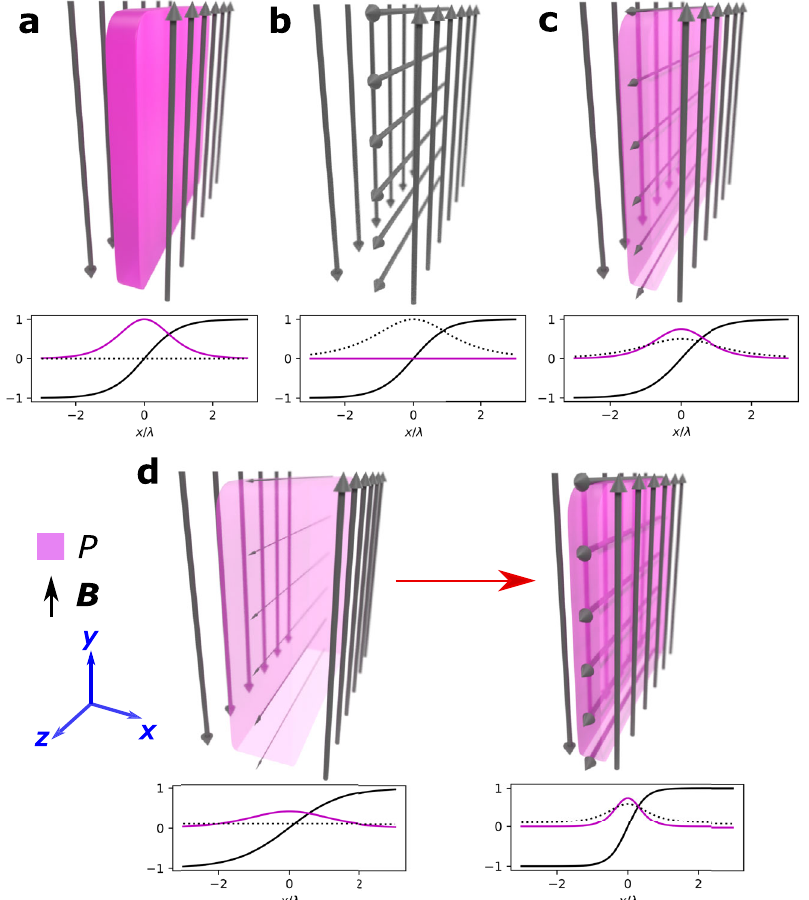
Fig. 1 | Current sheet types. Graphical illustrations of the a Harris equilibrium, b force-freeequilibrium,and c mixedequilibrium. d Theproposedprocessinwhich a disequilibrated Harris current sheet with a small seed guide fi eld relaxes and locally ampli fi es the guide fi eld in the process, thereby creating a mixed equili- brium. The arrowdirections and widths represent the magnetic fi elddirectionand